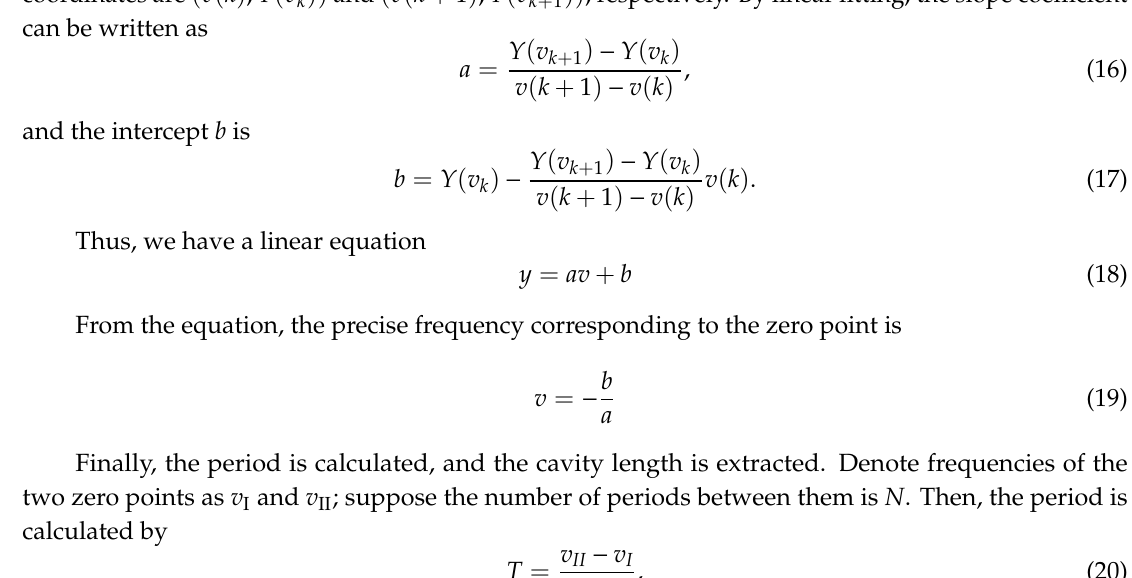
Figure 4. Simulated reflection spectrum of a fiber-optic FP sensor with a cavity length of 100 μ m.